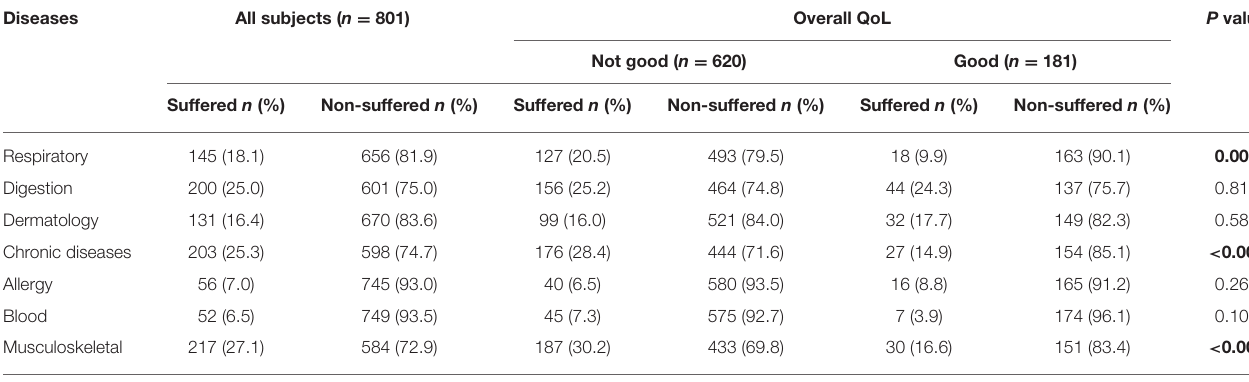
TABLE 3 | Health issues of the research subjects ( n = 801) and the association with QoL based on the chi-squared test. Diseases